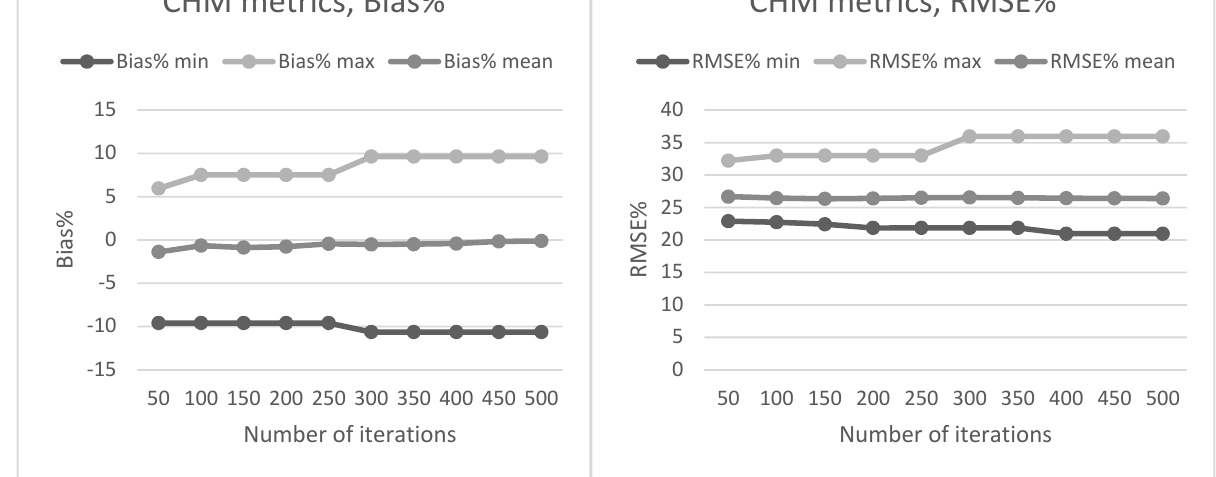
Figure A4. The effect of the number of iterations to estimated bias% and RMSE% of totalB when CHM metrics were used as predictor variables. The effect was analyzed by varying number of iterations from 50 to 500 with an interval of